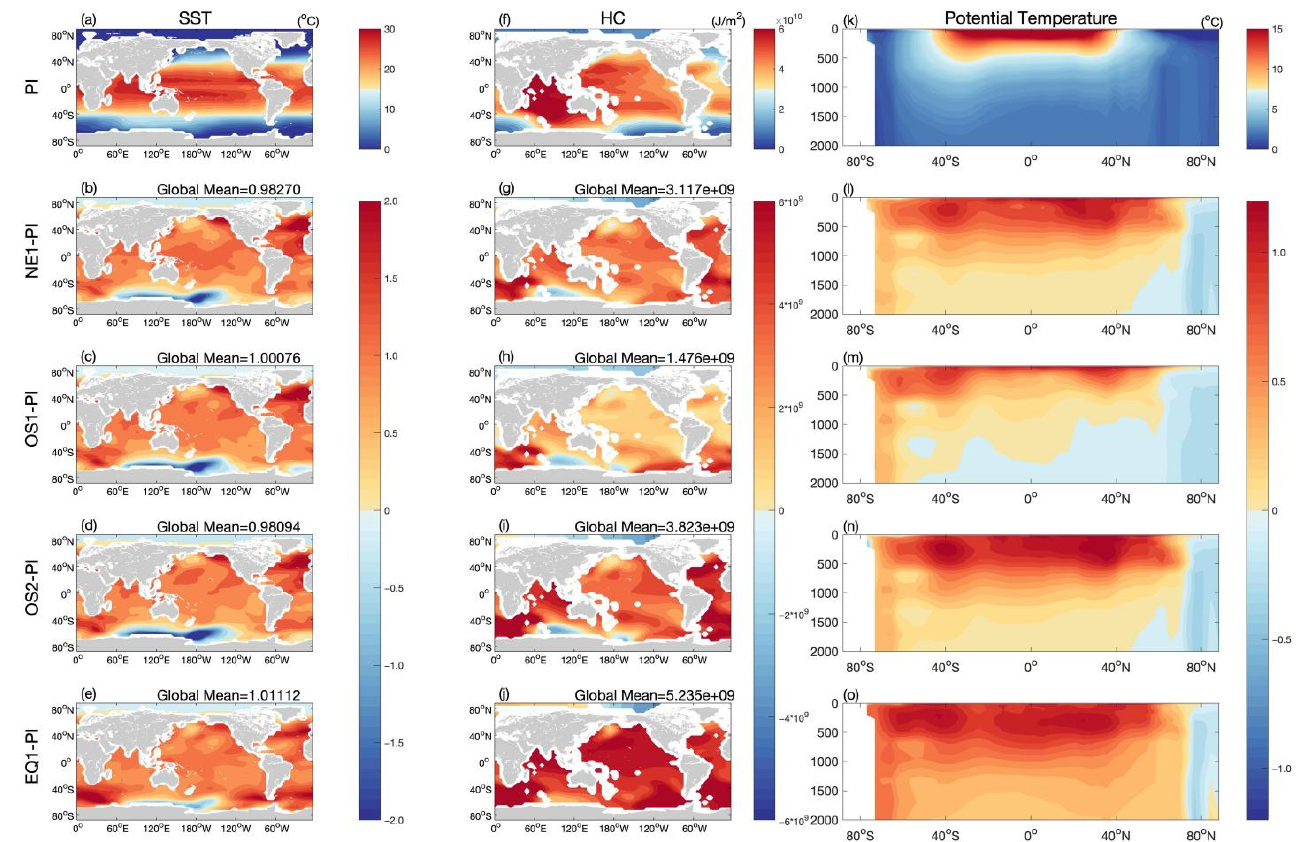
Figure 4. Spatial patterns of SST ( a ), HC ( f ), and vertical profile of ocean potential temperature ( k ). ( b – e , g – j , l – o ) The differences between the twenty-first century (2091–2100) relative to the PI (1896–1905) in the EQ, the NE, the OS, and the PI, respectively. The OS1 means the first time to achieve 1.5 ◦ C and the OS2 means the second time. Units are ◦ C, J/m 2 , and ◦ C for three columns. The spatial pattern of warming in both the horizonal and vertical axes at the time (ten year average) of 1.5 ◦ C warming for the four cases (NE1, OS1, OS2, and EQ1) are shown in Figure 4. The patterns and magnitudes of SST warming are very similar for all four cases, except that the Southern Ocean experiences much larger warming in the EQ1 case than in the other cases (Figures 4b–e and 5a–f). The pattern of HC changes is also similar among the four cases, but the magnitudes are quite different with EQ1 > OS2 > NE1 > OS1 (seen more clearly in Figure 5g–l), consistent with the duration and/or the amplitude of the forcings very different changes in the HC of the upper 2000 m (Figure 4h–i), because the warming reaches deeper in the latter than in the former (Figures 4m–n and 5q). Warming hardly reaches below 1000 m in OS1, but is well below 1000 m in OS2, and well below 2000 m in EQ1. The deepest warming is reached near the edge of Antarctica, where the bottom water forms in all cases. Around 40 ◦ S, the warming is also deep in the transient cases due to the deep mixed-layer depth there, delaying the surface